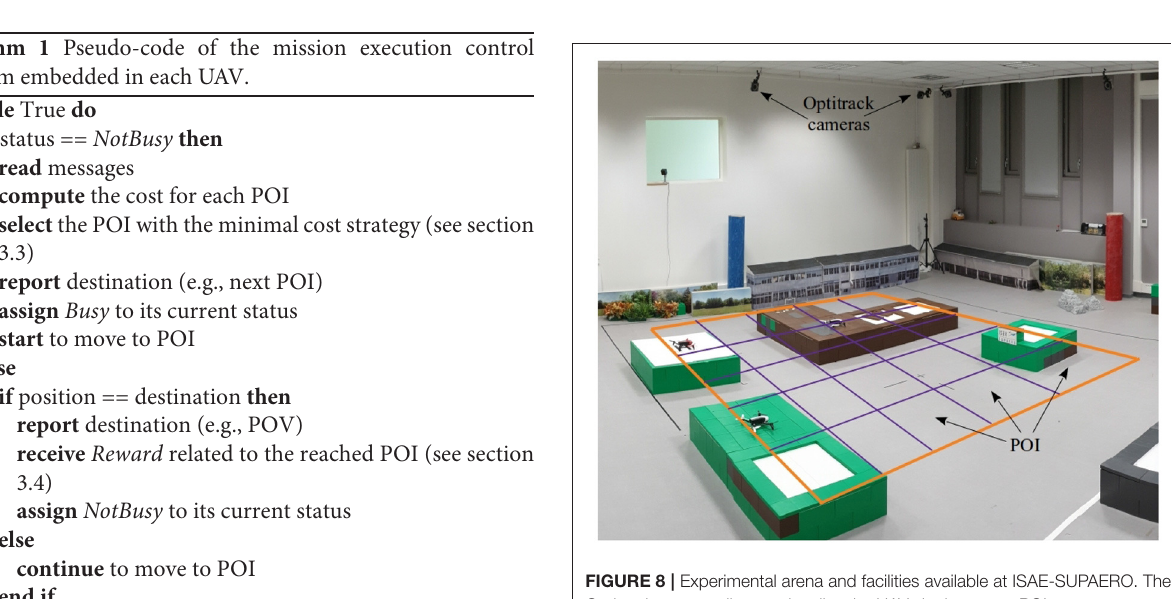
FIGURE 8 | Experimental arena and facilities available at ISAE-SUPAERO. The Optitrack system allows to localize the UAVs in the arena. POIs are schematized as five-by-five grid